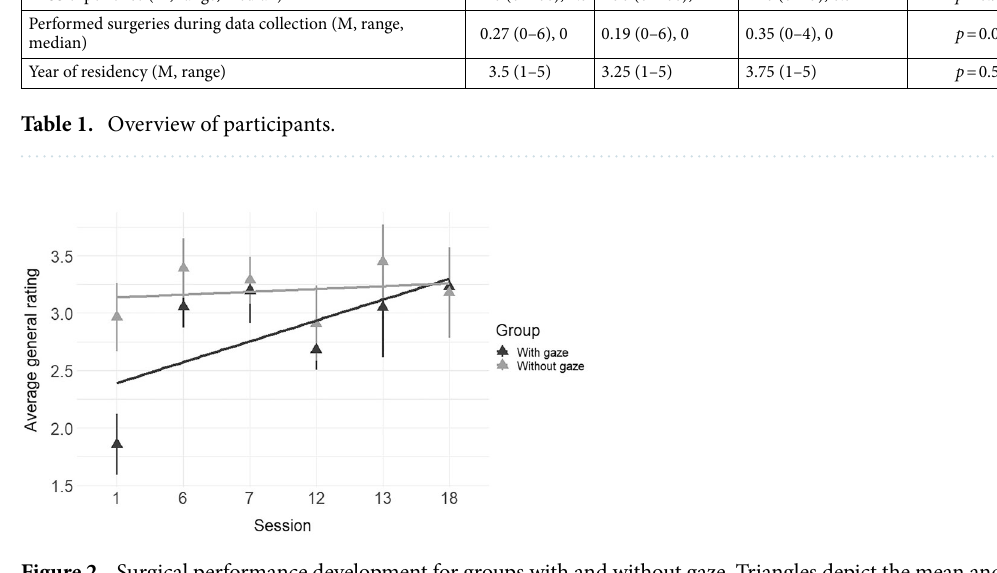
Figure 2. Surgical performance development for groups with and without gaze. Triangles depict the mean and vertical lines depict the standard error for the mean. The horizontal lines represent the linear effect of